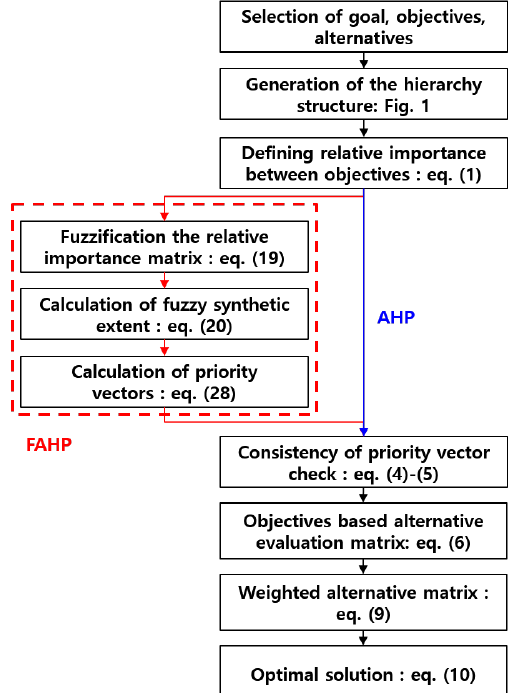
Figure 6. Step-wise algorithm of Fuzzy Analytic Hierarchy Process